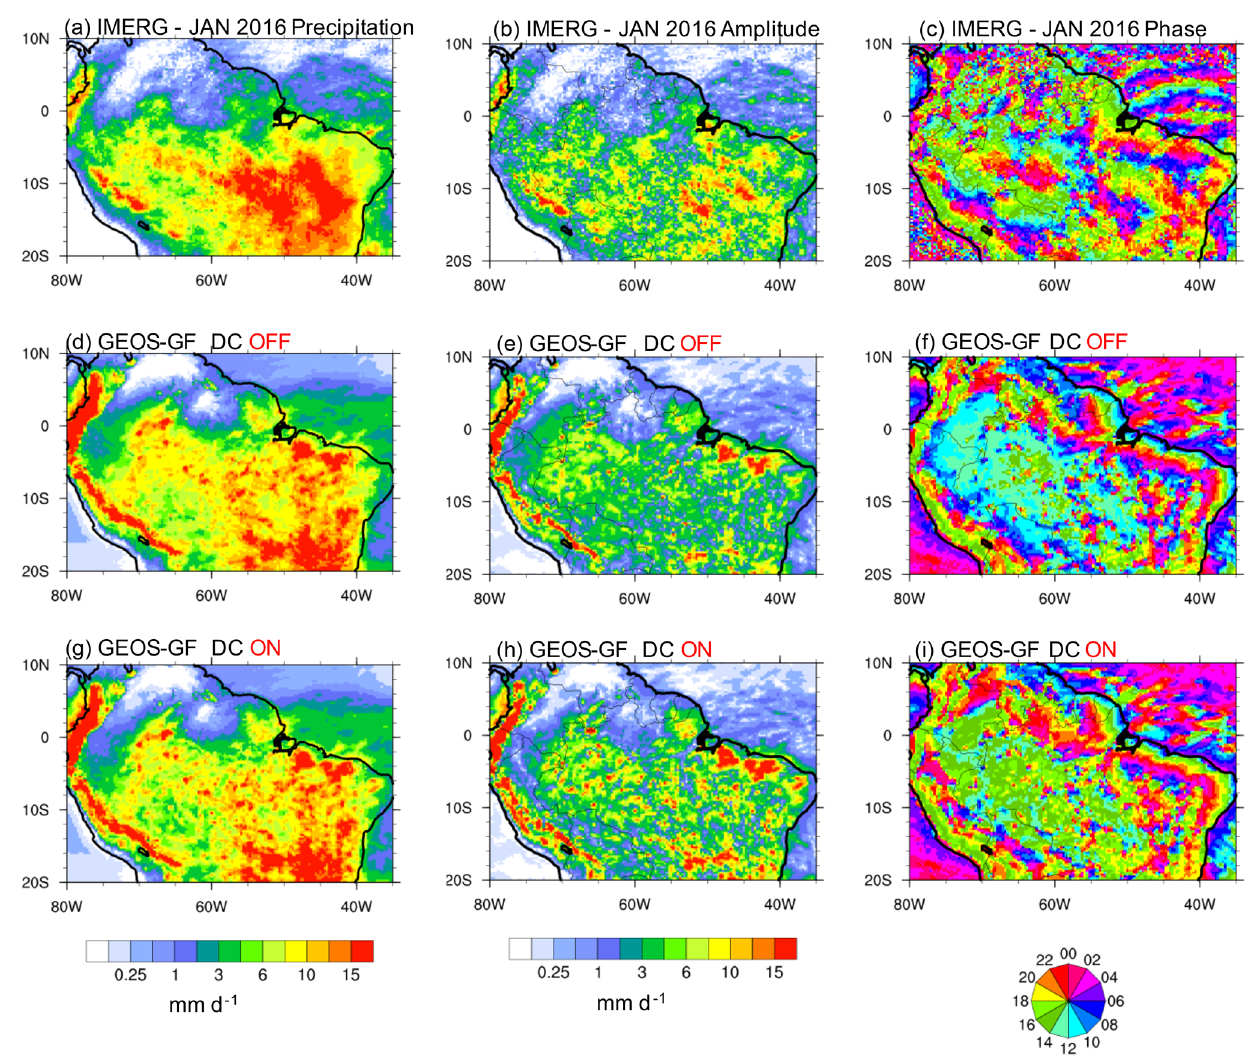
Figure 14. The January 2016 monthly mean precipitation, amplitude, and phase of the diurnal harmonic over the Amazon Basin. The top panels (a–c) show the quantities of the GPM IMERG retrieval. In the middle (d–f) and lower rows (g–i) , panels show model simulations with the diurnal cycle closure turned off and on,